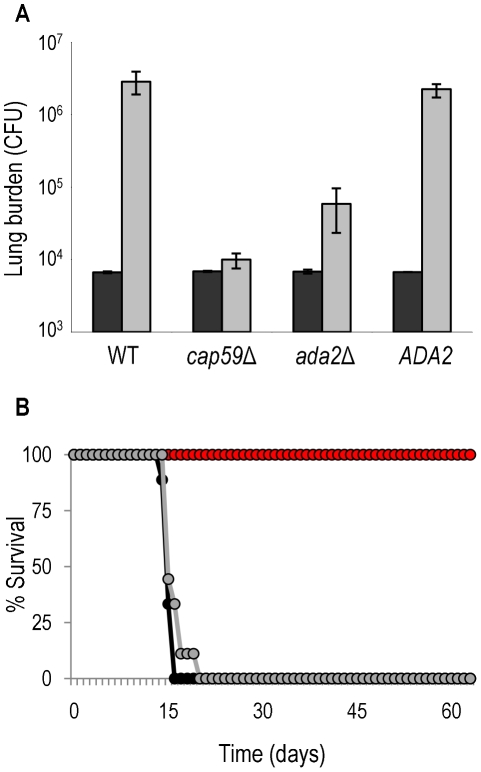
Ada2 is required for growth and virulence in mice.Panel A, C57Bl/6 mice were intranasally inoculated with 1.25 × 104 cells of the indicated strains, and total colony forming units (CFU) were isolated from the lungs after one hour (black bars) or one week (gray bars). The mean±maximum and minimum is shown. Panel B, survival curve of A/Jcr mice that were similarly inoculated with 105 cells of wild type (black), ada2Δ (red), or complemented ada2Δ (gray). Like those infected with ada2Δ, all mice that were infected in the same study with cap59 survived the entire period (not shown).